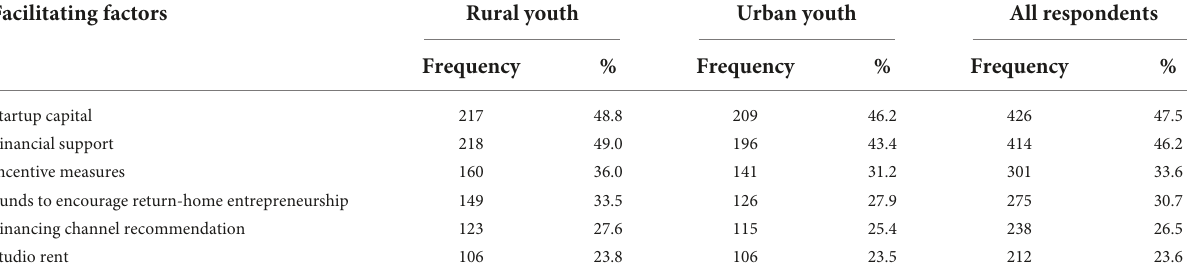
TABLE 13 Financial